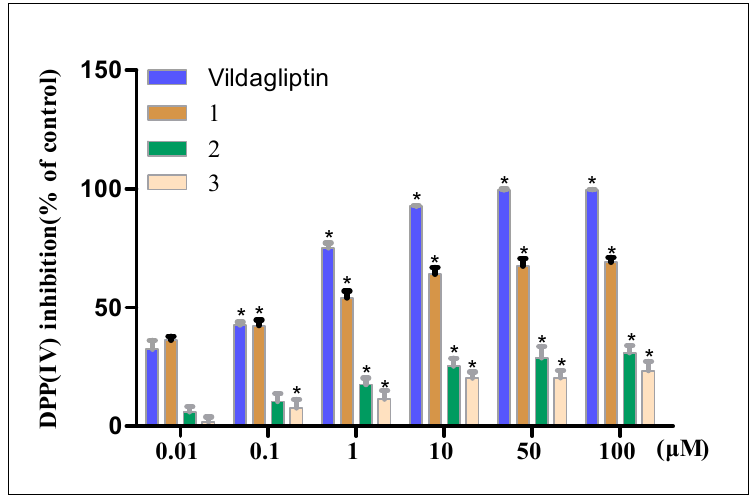
Figure 6 . Inhibitory activity of compounds 1 – 3 and vildagliptin (at different doses) against DPP-IV. * p < 0.05 compared with the 0.01 μ M group.